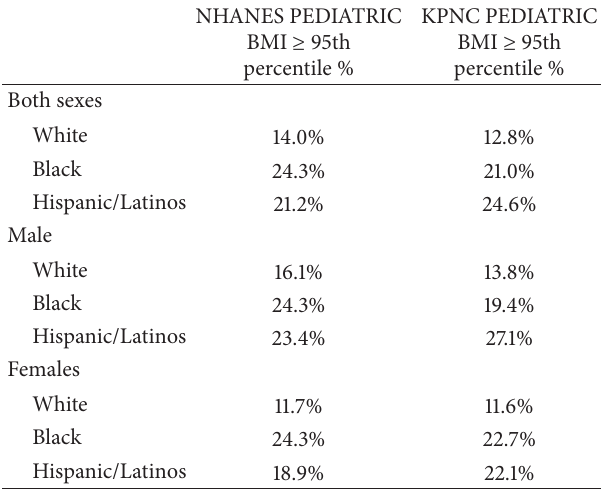
Table 5: Comparison of obesity in children aged 2–19 years in the NHANES and KPNC populations in 2009-2010, stratified by race and gender.